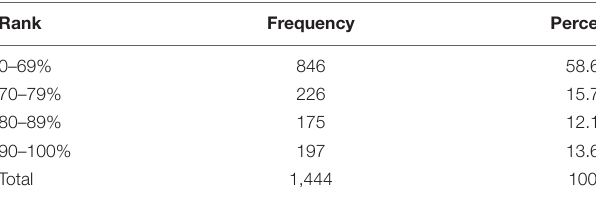
TABLE 2 | Frequency of esports player in each rank category.